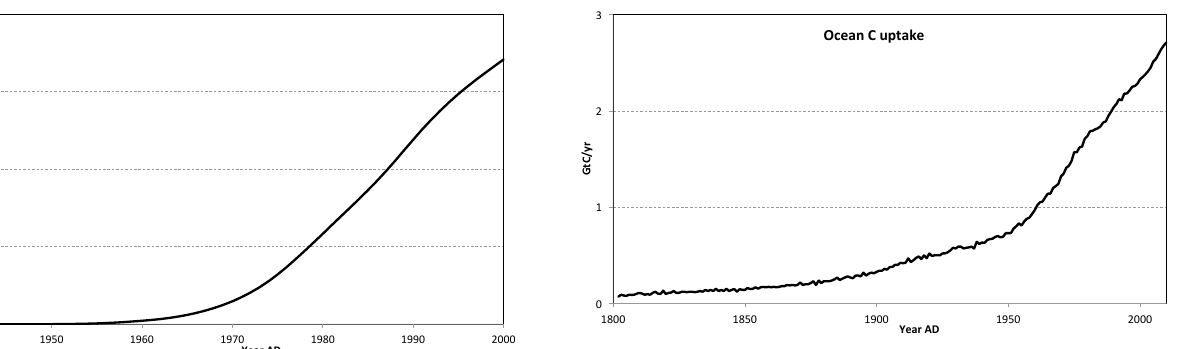
Fig. A2. Simulated oceanic inventory of CFC-11 (10 8 moles) in the 20th century.